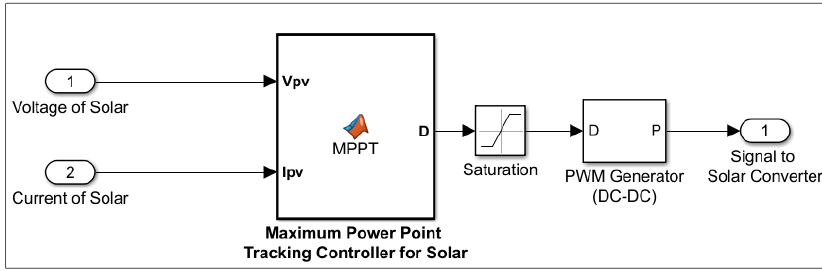
Figure 15. MPPT solar control system.